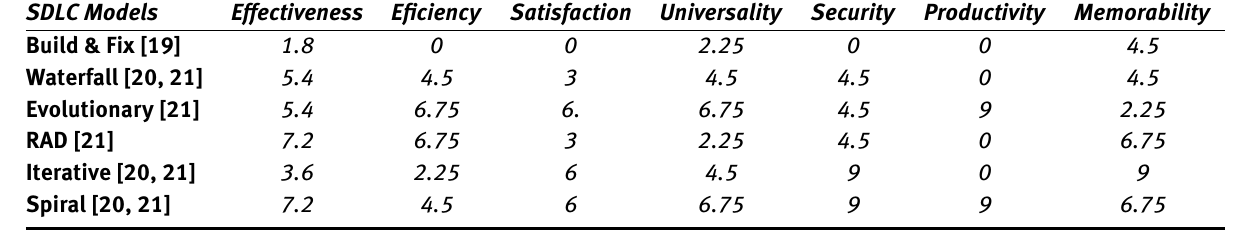
Table 3: Mapped Factor value for SDLC models on the scale of 0–9 SDLC Models